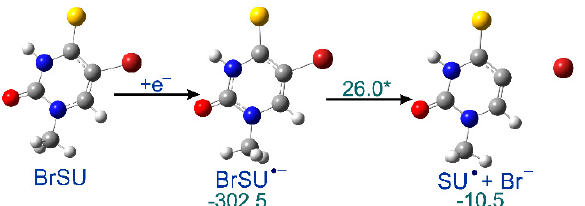
Figure 3. Calculated dissociative electron attachment (DEA) profile for BrSU. After the initial electron attachment to BrSU, the anion radical BrSU •– is formed, and subsequently dissociates via a green, were calculated as the difference between the given state and the previous stable one, the